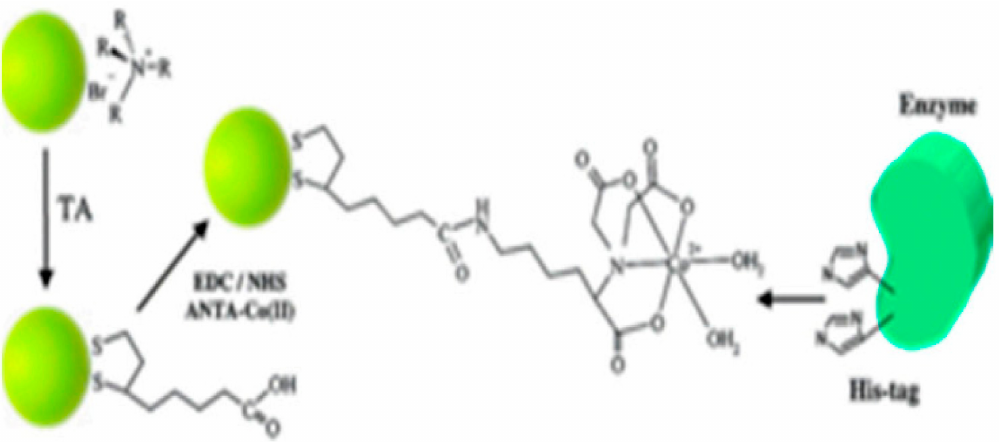
Figure 22. By immobilizing completely functioning proteins on the Au NP surface, biomolecules are grafted on Au NPs by the use of thioctic acid. reproduced with reference permission [162], ACS,